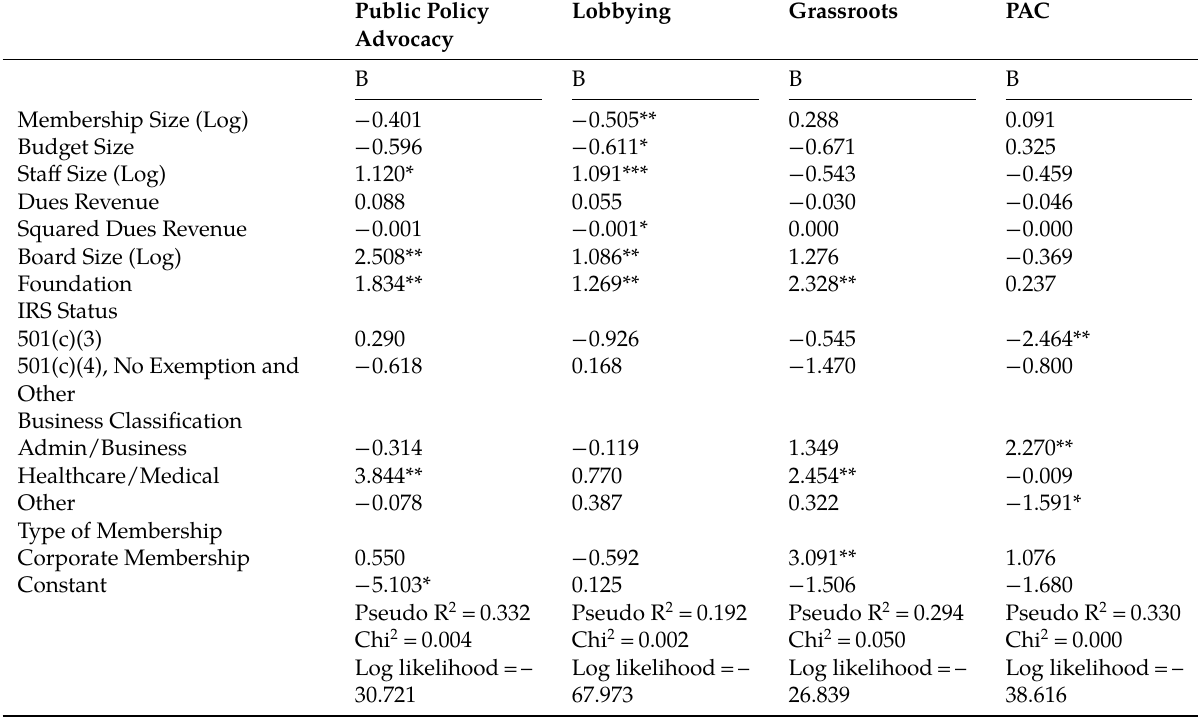
Table 3: Political engagement logistic